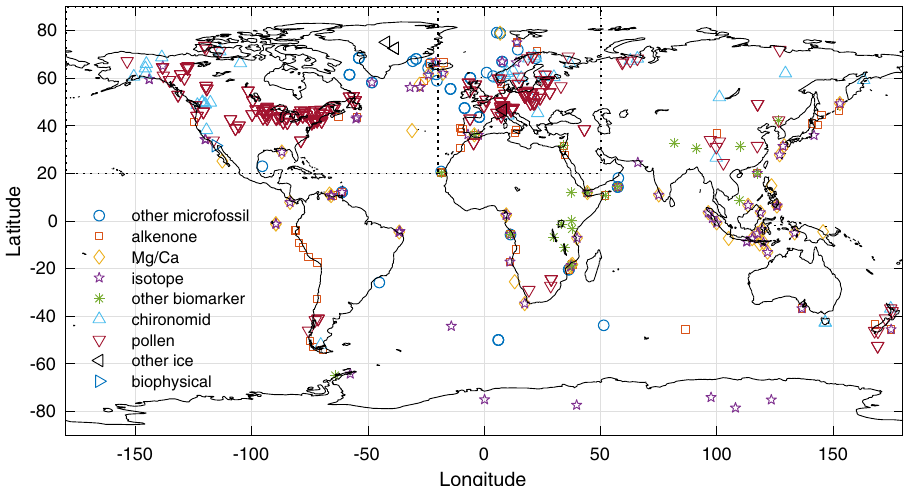
Fig. 4 | Map of the paleotemperature records. Map of the paleotemperature records selected and used in this study. Dotted lines represent the two domains